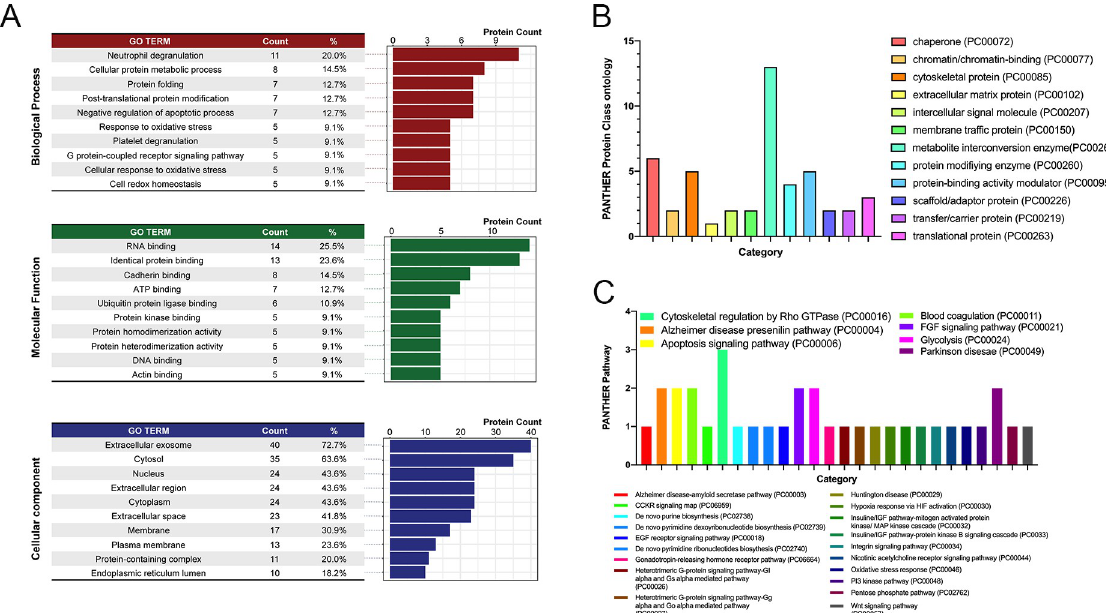
Fig 6. Gene ontology annotation of differentially expressed proteins, and PANTHER pathway analysis. (A) The 55 proteins exhibiting significant changes were searched against GO categories from the UniProt database, including biological process, molecular function, and cellular component. Proteins were counted in each ontology they belonged to, and percentages indicate the proportion of the 55 proteins belonging to each class. Bar charts indicate the number of proteins differentially expressed after RSV infection that belong to a specific PANTHER (B) Protein Class ontology or (C) Pathway. Three proteins (cofilin-1, profilin-1, and tubulin β -chain) were associated with the “Cytoskeletal Regulation by Rho GTPase” pathway. Five other pathways matched two proteins, and 19 pathways matched a single protein.